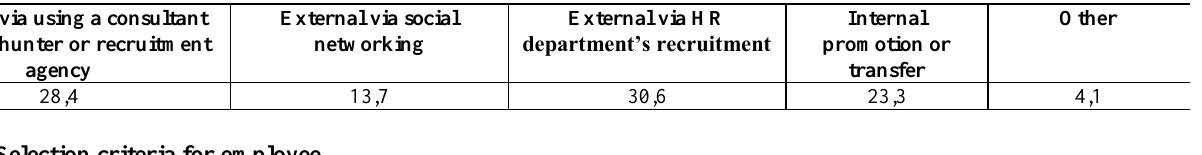
Table 2: Selection criteria for